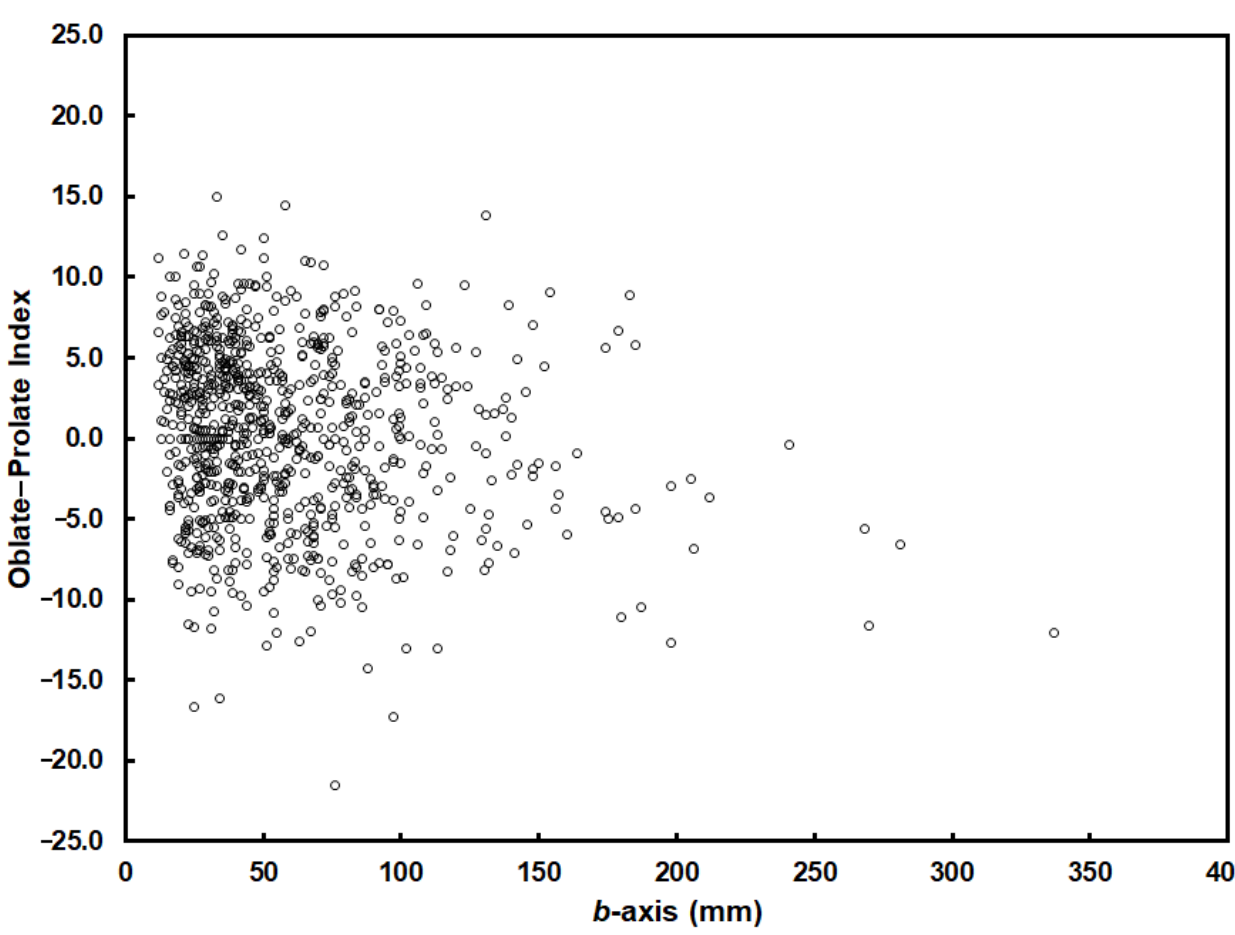
Figure 15. The Oblate–Prolate Index of fluvial gravels of Navilawa Monzonite from Stations 1–7 along the Sabeto River of western Viti Levu, Fiji as a function of particle b -axis length.